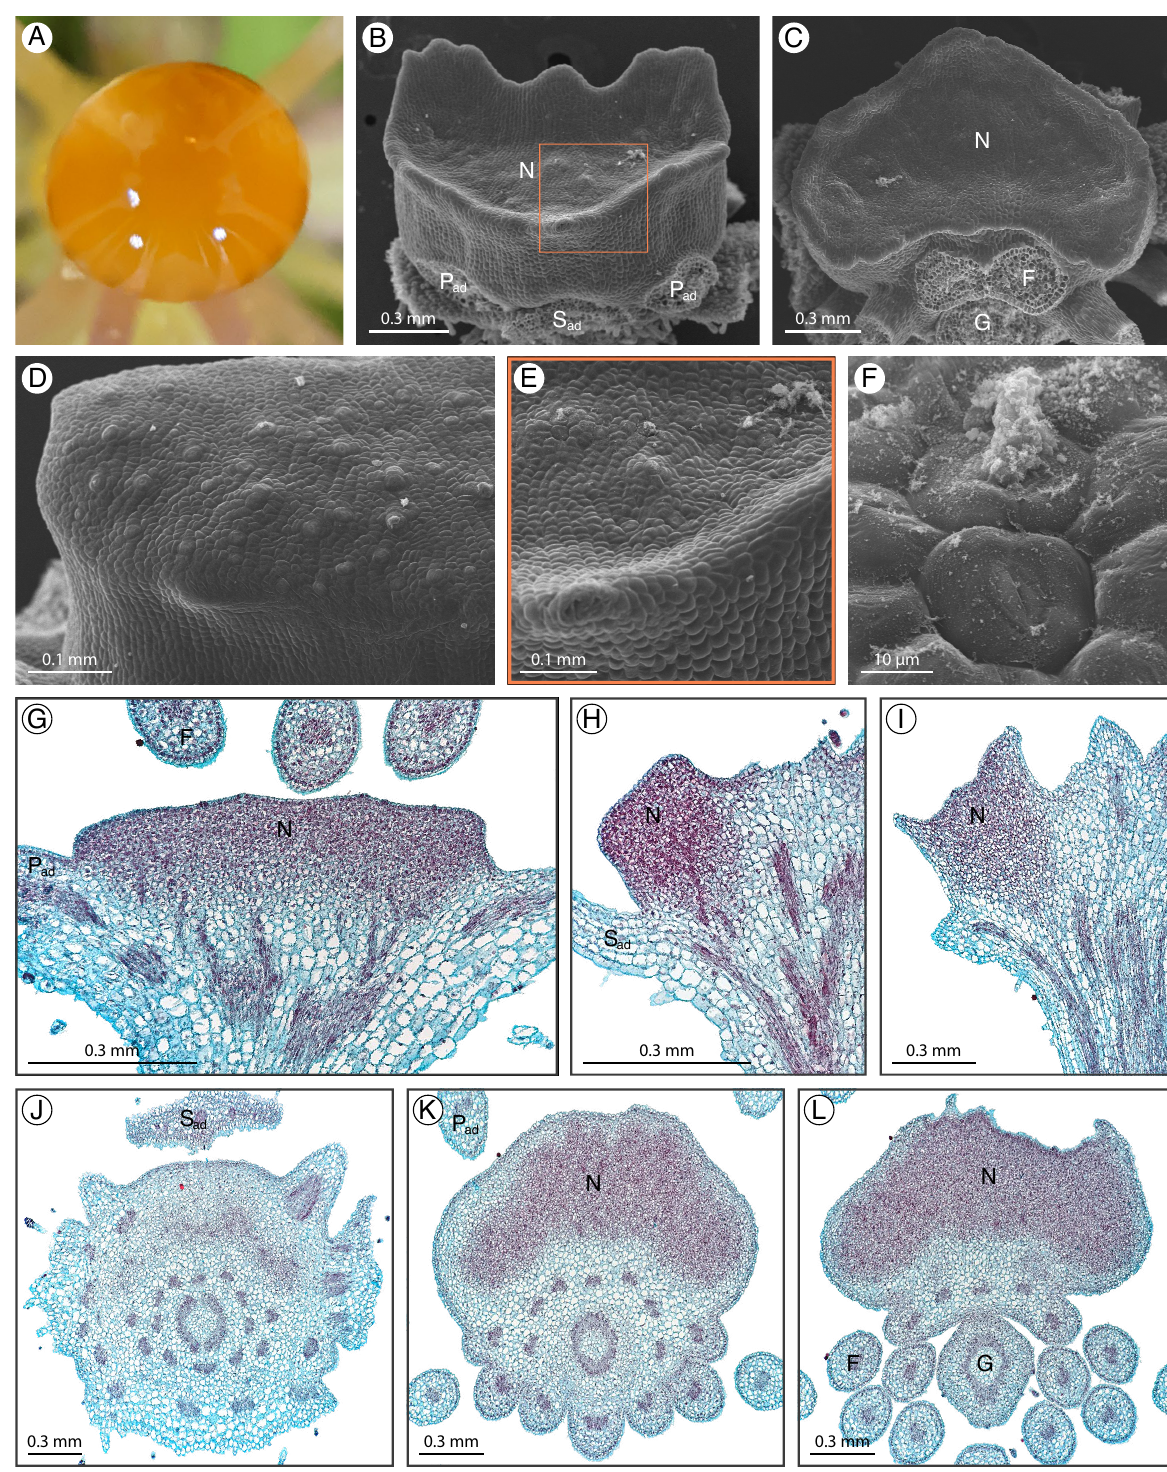
Figure 7. Polanisia dodecandra nectary ( A ) photograph, ( B – F ) scanning electron micrographs, and ( G – L ) fast green and safranin O-stained sections. ( A ) Apical view of the nectary. ( B ) Adaxial view of the nectary. ( C ) Apical view of the nectary. ( D – F ) Adaxial view close-ups: ( D ) bud stage nectary, ( E ) anthetic stage nectary, corresponding to the box in ( B ), and ( F ) anthetic stage nectarostomata. ( G ) Longitudinal section (frontal plane) of the intermediate stage nectary. ( H , I ) Longitudinal section (sagittal plane): ( H ) intermediate stage nectary and ( I ) anthetic stage nectary. ( J – L ) Transverse sections of the nectary from proximal to distal positioning. All images are of anthetic stage specimens unless indicated otherwise. F: filament; G: gynophore; N: nectary; P ad : adaxial petal; S ad : adaxial